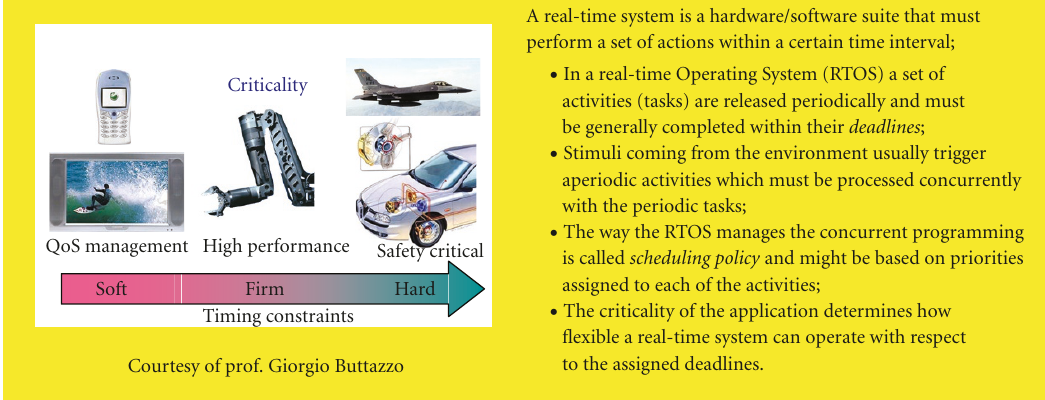
Figure 2: Some concepts related to Real-Time.